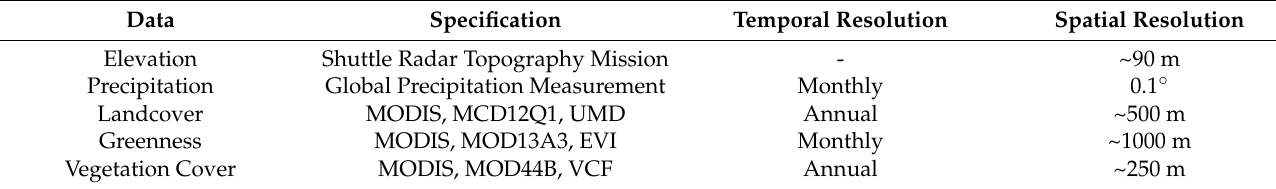
Table 1. Summary of input